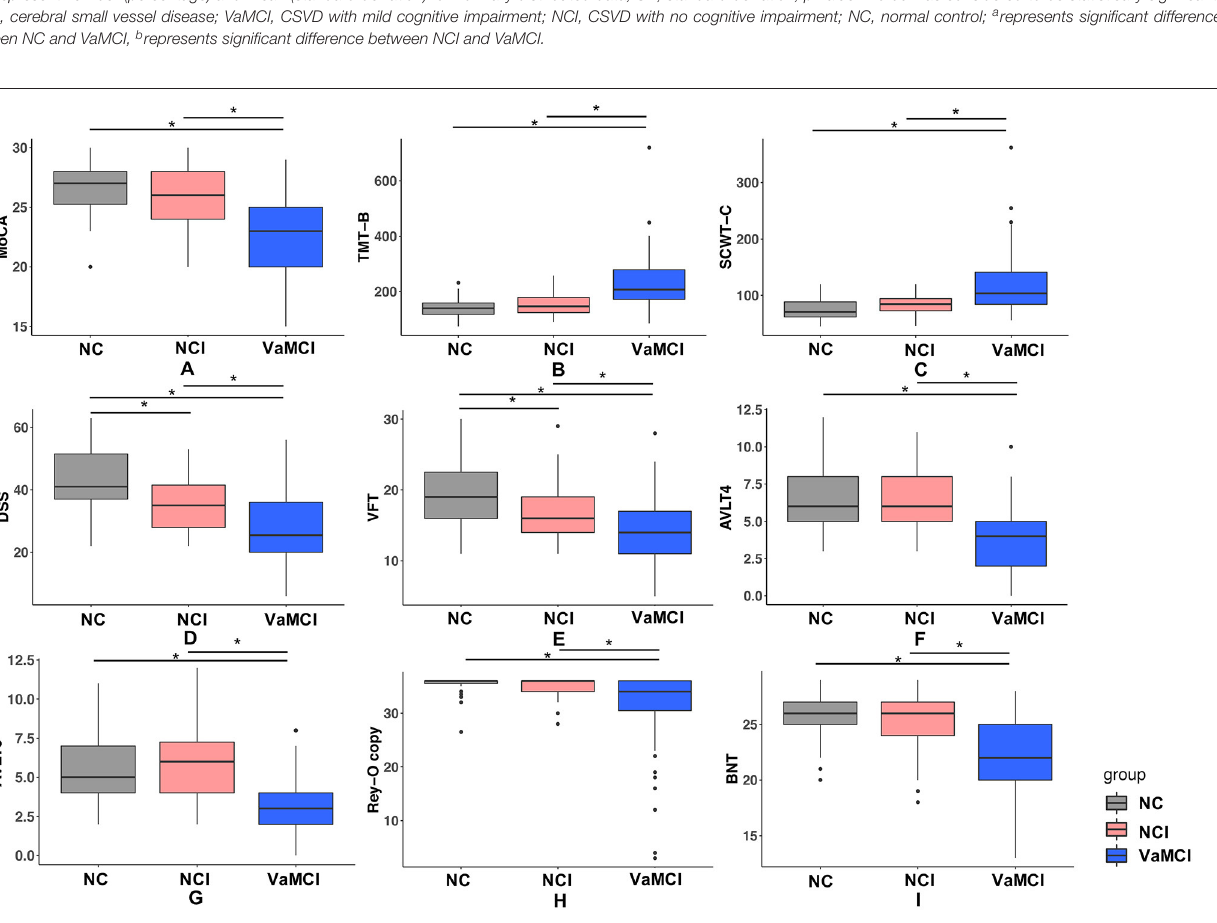
FIGURE 1 | Results of group comparison for different cognitive tests. (A–I) One-way ANOVA test was applied to conduct the group comparison of cognitive scores. p -value < 0.05 was considered to be statistically significant, * represents p < 0.05. VaMCI, CSVD with mild cognitive impairment; NCI, CSVD with no cognitive impairment; NC, normal control; MoCA, Montreal Cognitive Assessment; TMT-B, Trail-Making Tests B; SCWT-C, Stroop color word test C; DSS, digital span substitution test; VFT, verbal fluency test; AVLT-4/5, auditory verbal learning test short and long delayed free recall; BNT, Boston Naming Test; Rey-O copy, Rey-Osterrieth Complex Figure Test